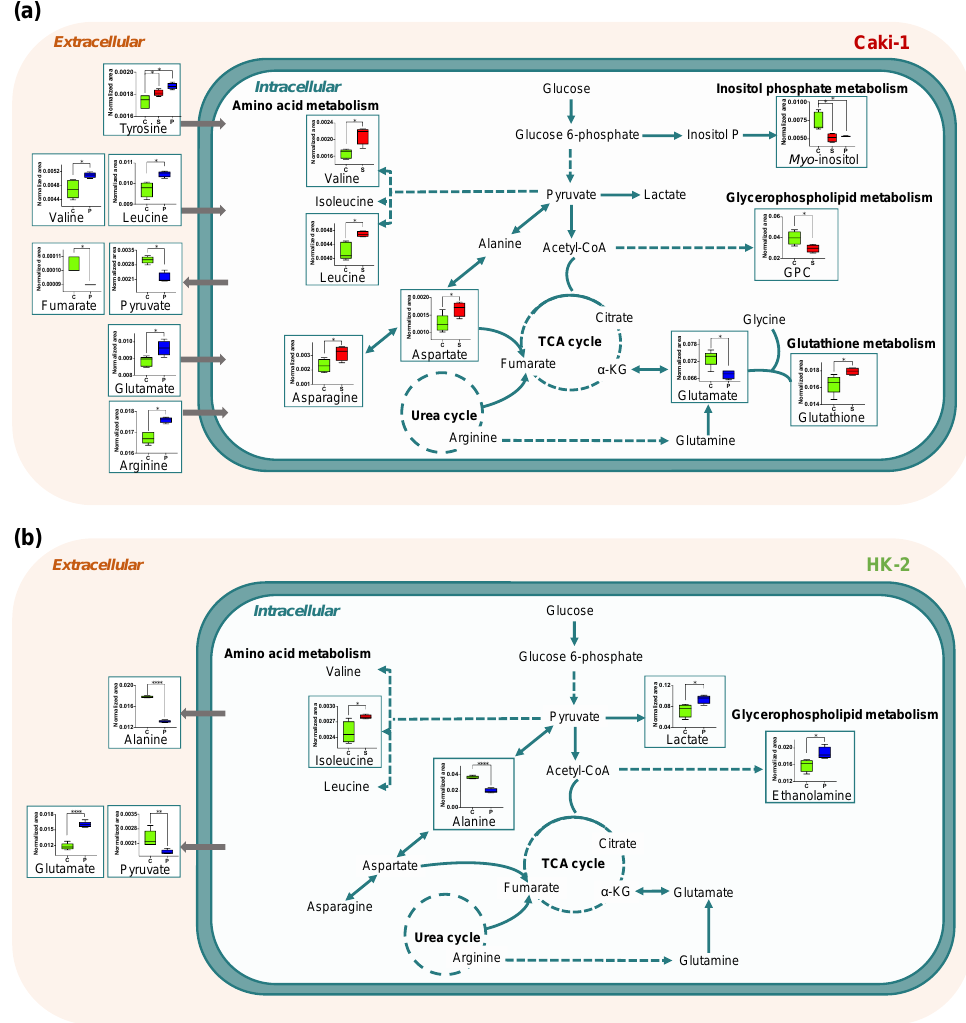
Figure 6. Overview of the intracellular and extracellular metabolic alterations occurring in ( a ) metastatic RCC cells (Caki-1) and ( b ) non-tumoral renal cells (HK-2) after exposure to 2 µM sunitinib (S, red) or 50 µM pazopanib (P, blue) compared with the corresponding controls (C, green) ( * p < 0.05, ** p < 0.01, **** p < 0.0001). The arrows indicate metabolites consumed ( → ) and excreted ( ← ) considering the non-exposed cells (control) compared with blanks. GPC: glycerophosphocholine.